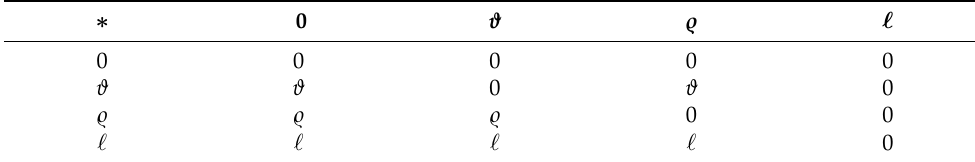
Table 3. Cayley’s table for ∗